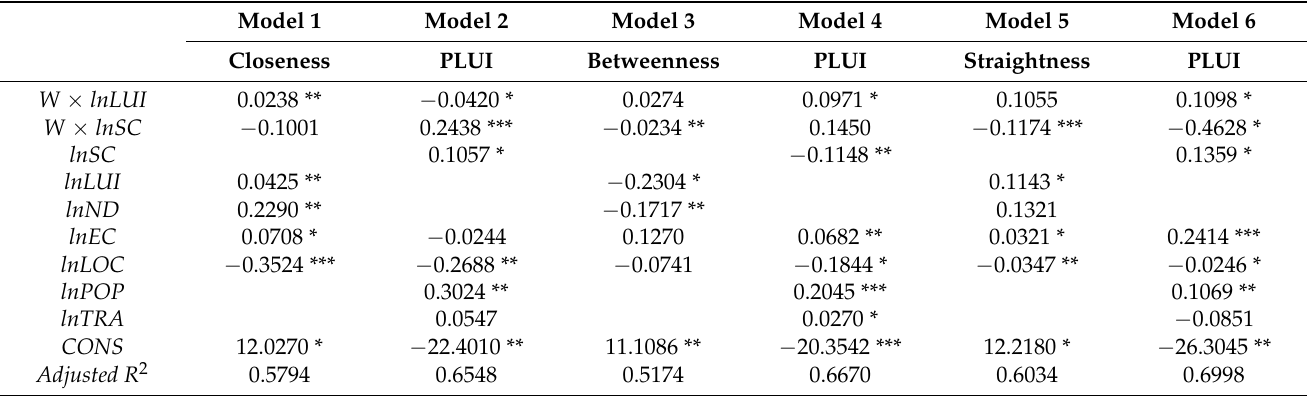
Table 4. Regression results of SC and